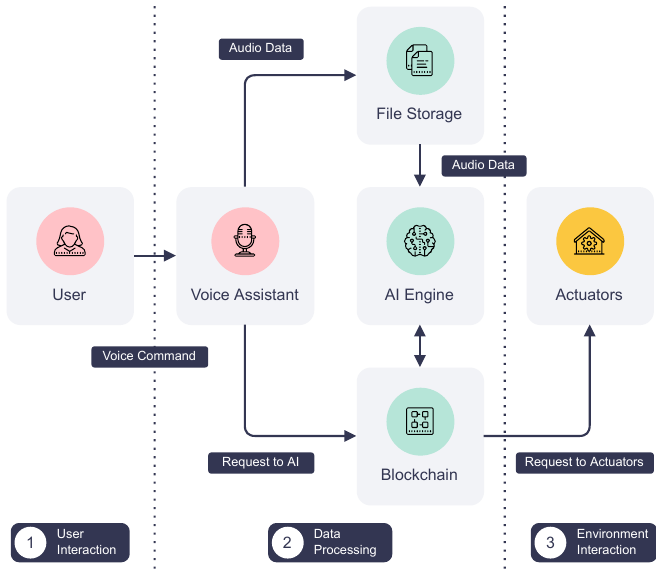
Figure 6. The architecture and data flow of Parrot.